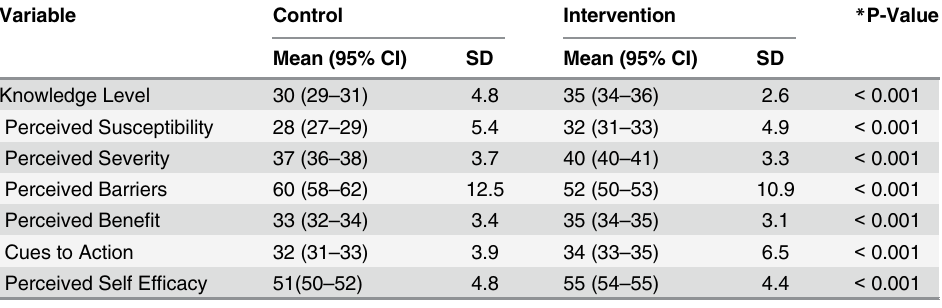
Table 2. Endpoint knowledge level and each HBM domains mean scores difference between interven- tion and control groups, adjusted for clusters.